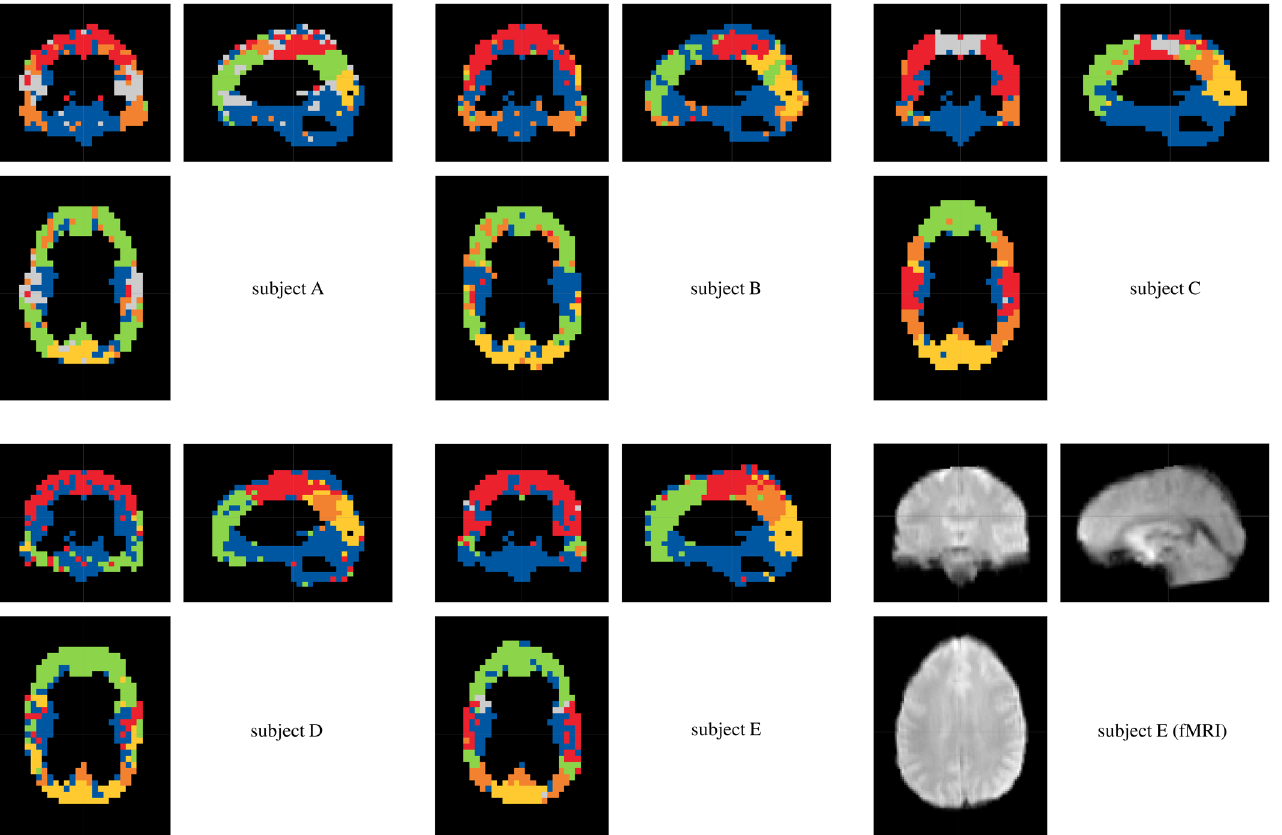
Fig 11. Results of the resting state fMRI functional segmentation for different subjects (85% variance explanation, 95% edge weight distribution percentile, “ Louvain ” directed). Each color represents one (subject-individual) identified module. As reference, one fMRI volume is shown bottom right (registered to the standard MNI152